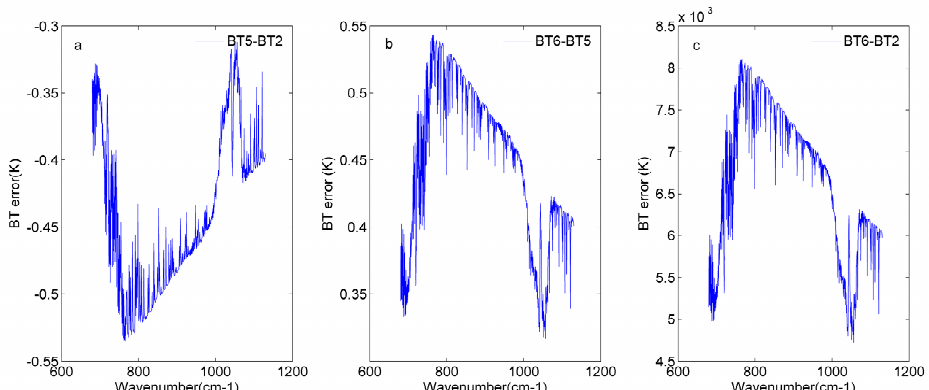
Figure 13. BT errors before and after nonlinearity correction for detector 81: ( a ) BT error in the input spectrum (BT2) and the spectrum with the nonlinearity response (BT5); ( b ) BT error in the spectrum with nonlinearity response (BT5) and the spectrum after nonlinearity correction (BT6); ( c ) BT error in the spectrum after nonlinearity correction (BT6) and the input spectrum (BT2).